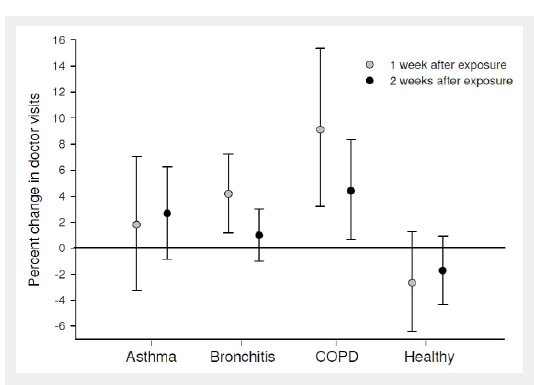
Average percent change * in number of doctor visits following a 10 µg/m 3 increase in NO 2 concentration. * For each subgroup, areas under the curve were estimated from adjusted conditional logistic regression models to approximate the average percent change in number of doctor visits over 1 and 2 week periods following a 10 µg/m 3 increase in exposure to NO 2 concentration on a given